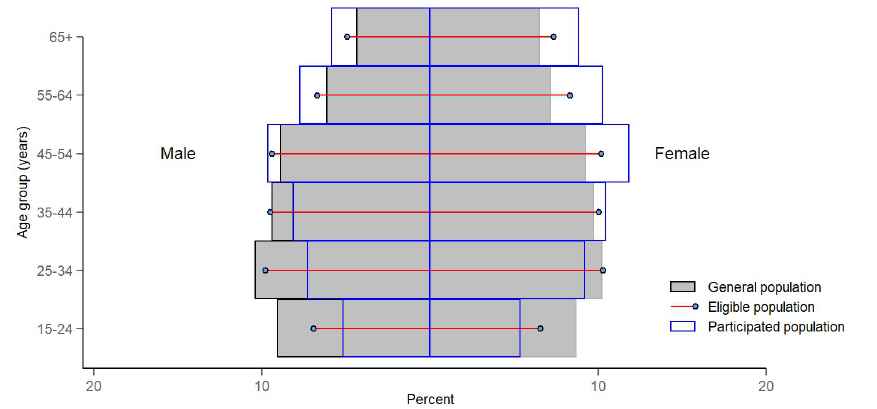
Fig 2. Comparison of age-sex distribution for the general, eligible and participated population.